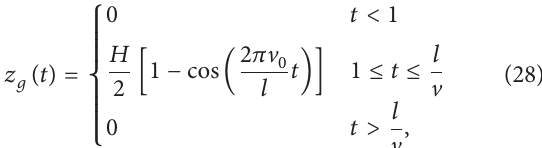
Figure 13: The road inputs of four